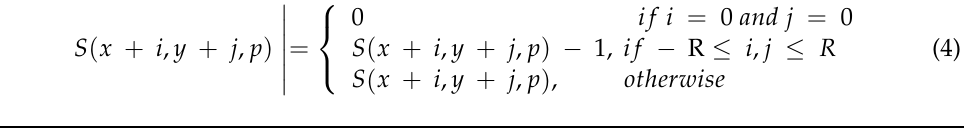
Algorithm 1 Neighborhood suppression time surface